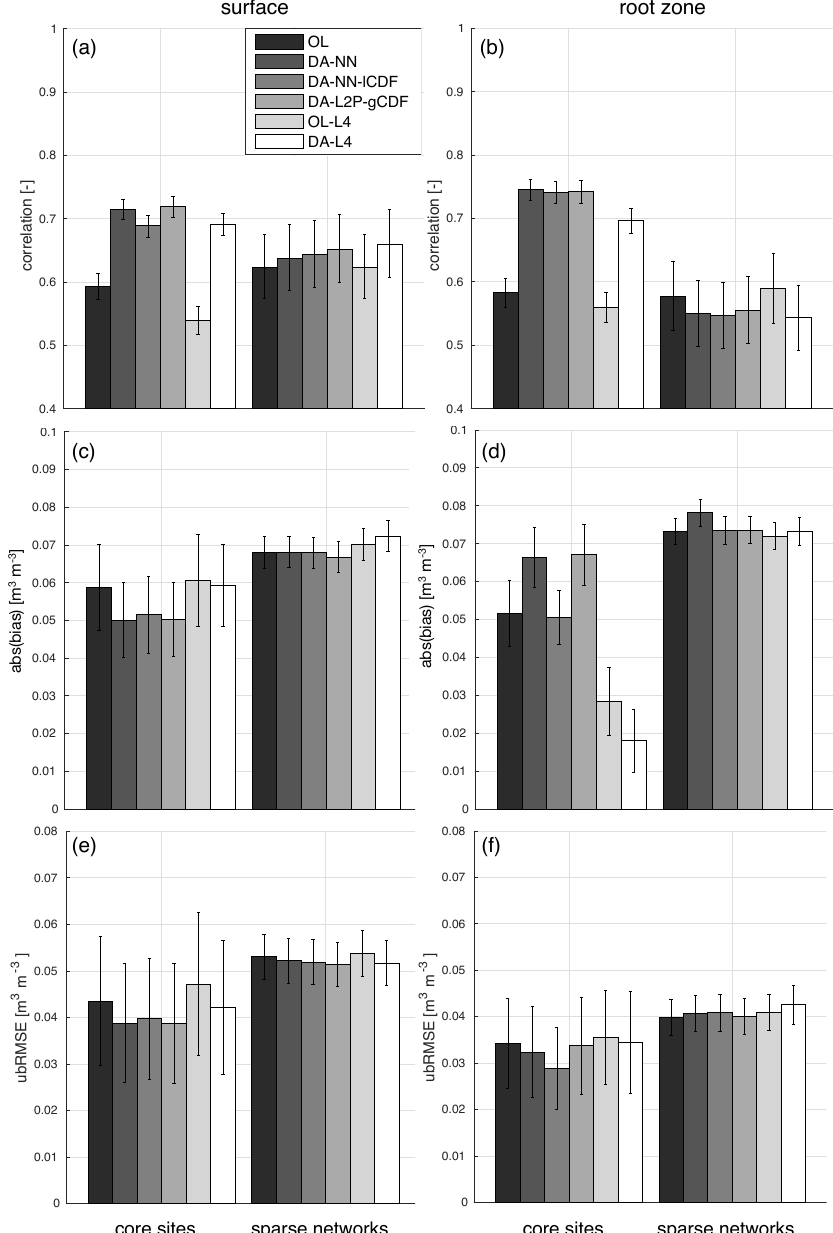
Figure 4. Average metrics for all experiments against core site and sparse network in situ measurements. Shown are ( a ) the surface correlation, ( b ) root zone correlation, ( c ) surface absolute bias, ( d ) root zone absolute bias, ( e ) surface ubRMSE, and ( f ) root zone ubRMSE. The error bars indicate the 95% confidence